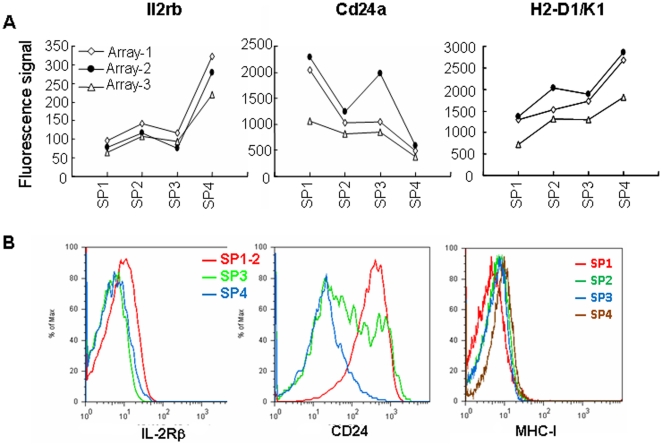
Expressions of Il2rb, Cd24, and H2-D1/K1 among the four subsets of CD4+ SP thymocytes.(A) Gene expression of Il2rb, Cd24a, and H2-D1/K1 by the microarray analysis. (B) Expression of IL-2Rβ, CD24, and MHC class I by flow cytometry.